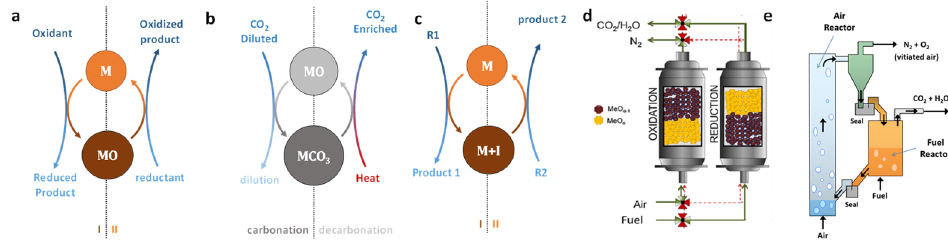
Figure 1. Scheme of some chemical looping processes for: ( a ) redox reactions and ( b ) carbon dioxide separation. In ( a , b ) reduction and decarbonation can equally be achieved by oxygen and carbon dioxide partial pressure decrease, e.g., through an inert gas feed. ( c ) Chemical looping transfer, where solid materials pass on surface reaction intermediates (carbon, -OH, S,) between separate reactions (R1 and R2). Chemical looping using ( d ) fixed-bed reactors and ( e ) two interconnected fluidized-bed reactors.